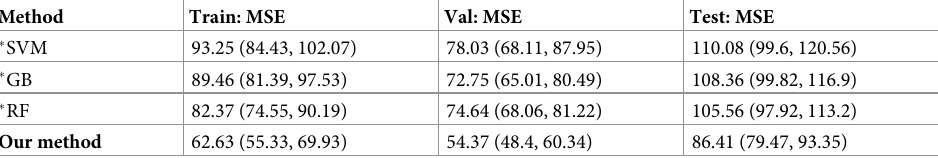
Table 6. The comparison of the MSE values of the proposed CNN method and classical machine learning methods. Method Train: